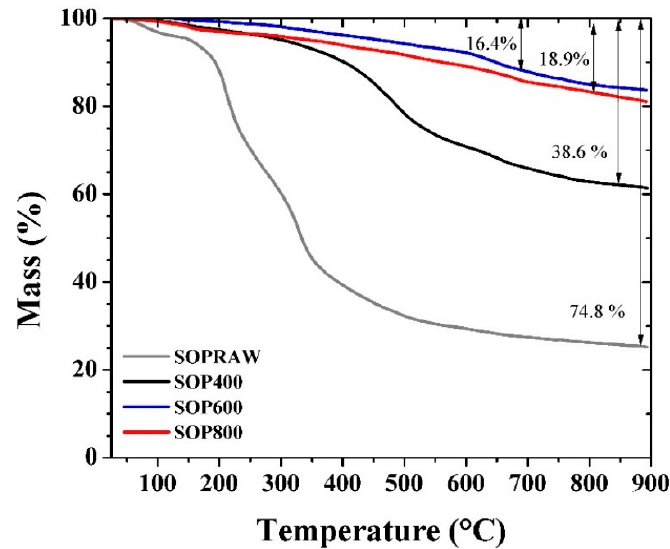
Figure 4. TG curves of the SOPRAW and biochars.